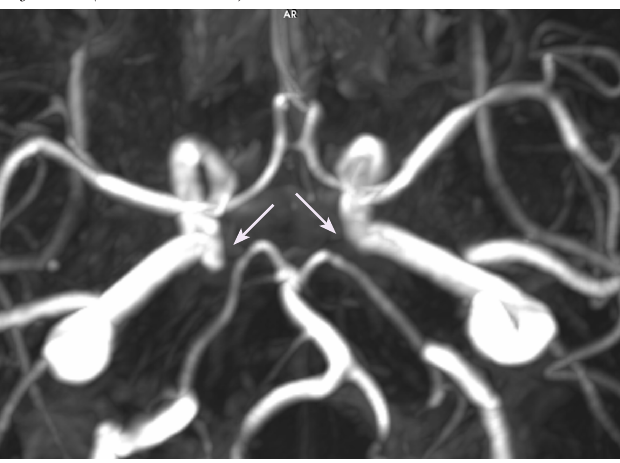
Figure 4. Absent Left A1 (Arrow) and Hypoplastic Left P1 (Arrow head).